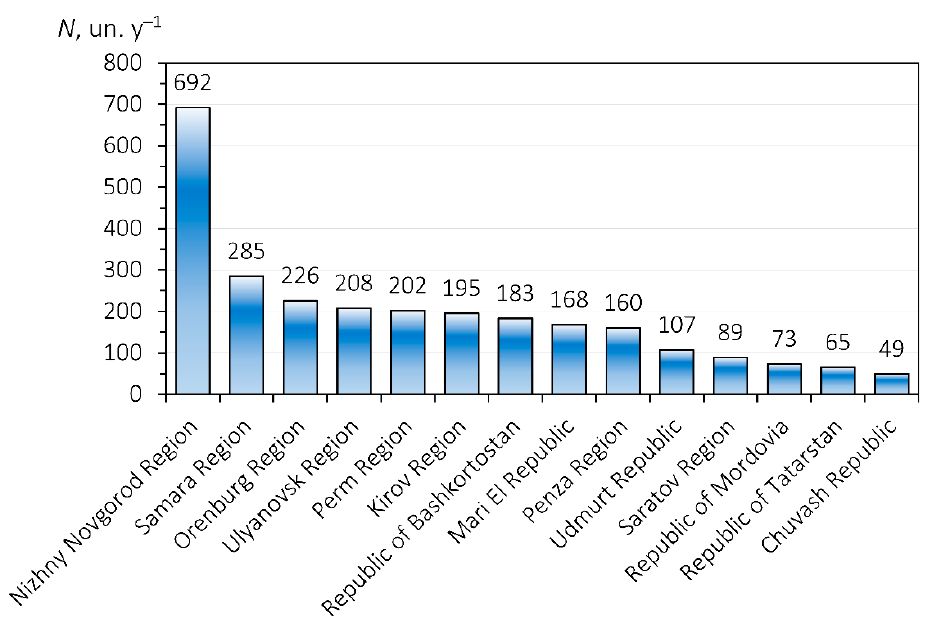
Figure 2. The number of forest fires per annum ( N , averaged for 1992–2020) by the administrative regions of the Volga Federal District (see Figure 1).